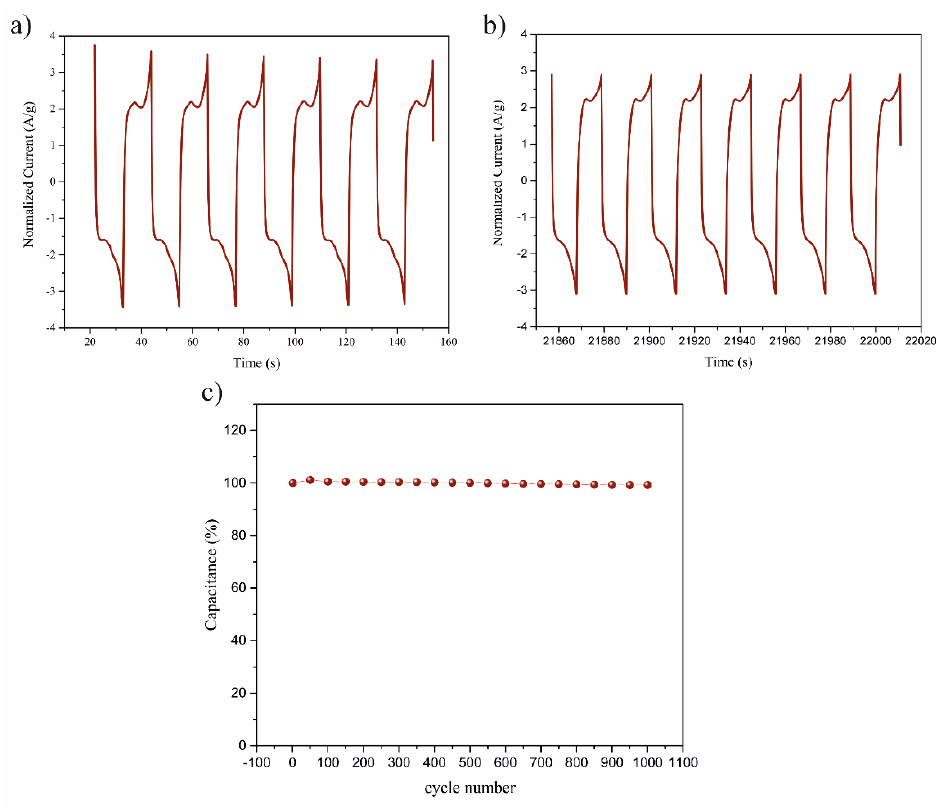
Figure 10. Stability studies of pyr -CNOs based on the CV measurements (1000 cycles): ( a ) the first 8 cycles, ( b ) the last 8 cycles, and ( c ) capacitive current values as a function of cycling numbers.